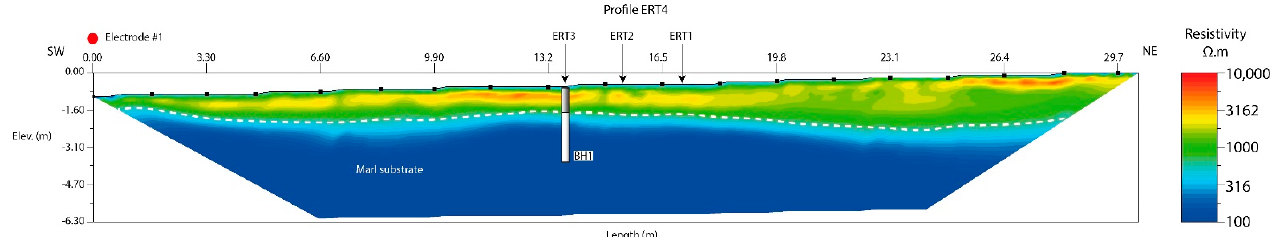
Figure 3. Perpendicular ERT profile ERT4. The other three profiles intersect vertical with arrows to mark the position of ERT1-ERT3.